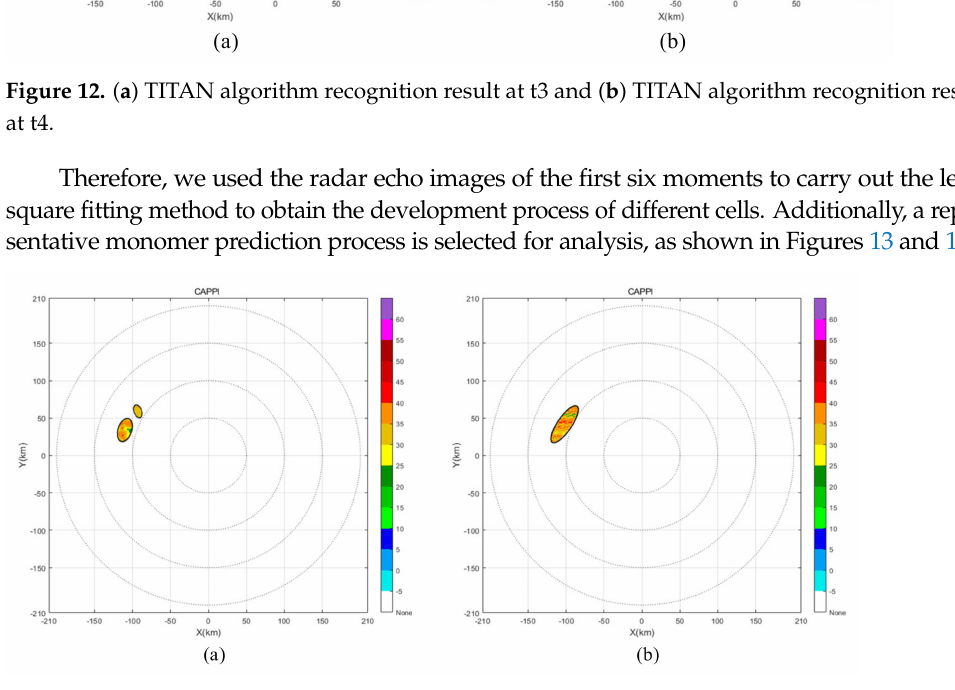
Figure 13. ( a ) Actual position of the monomer at 0.5 h and ( b ) predicted position of the monomer at 0.5 h.